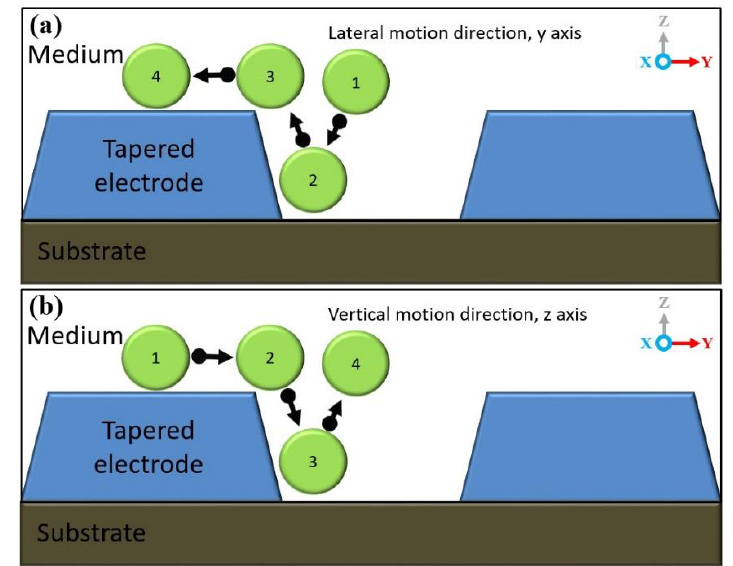
Figure 9. ( a ) At the i nput frequency 10 KHz, 10 μm Ps attracted laterally in the y-axis, P DEP , and ( b ) at the i nput frequency 2 MHz, 10 μm Ps vertically repelled in the z-axis, N DEP.